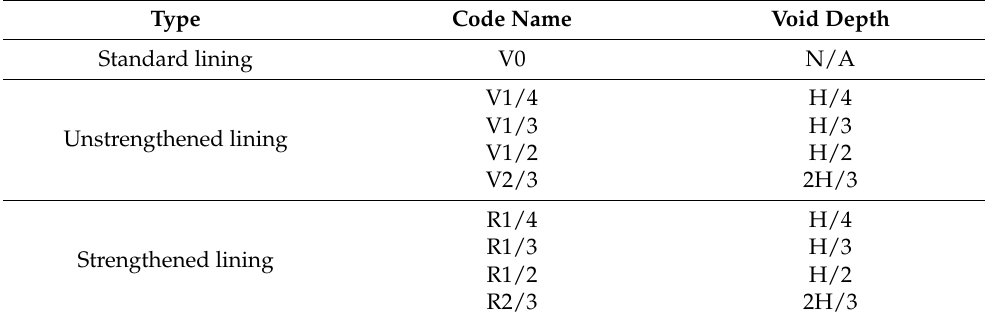
Figure 1. Model setup. Table 1. Details of the